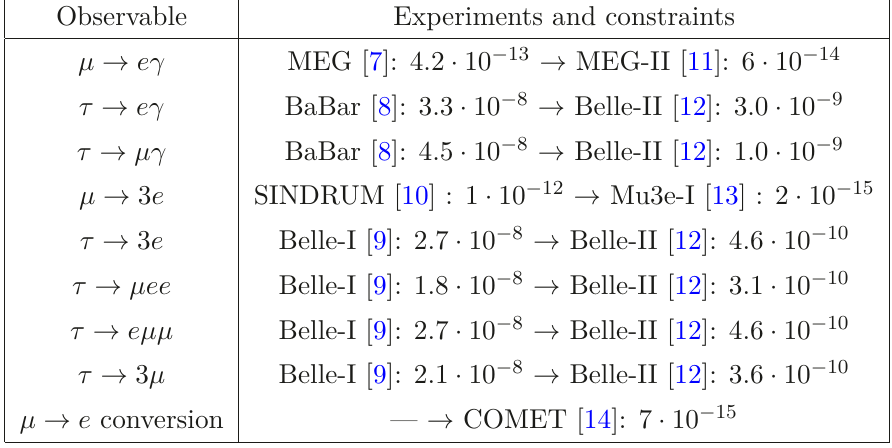
e conversion, we →